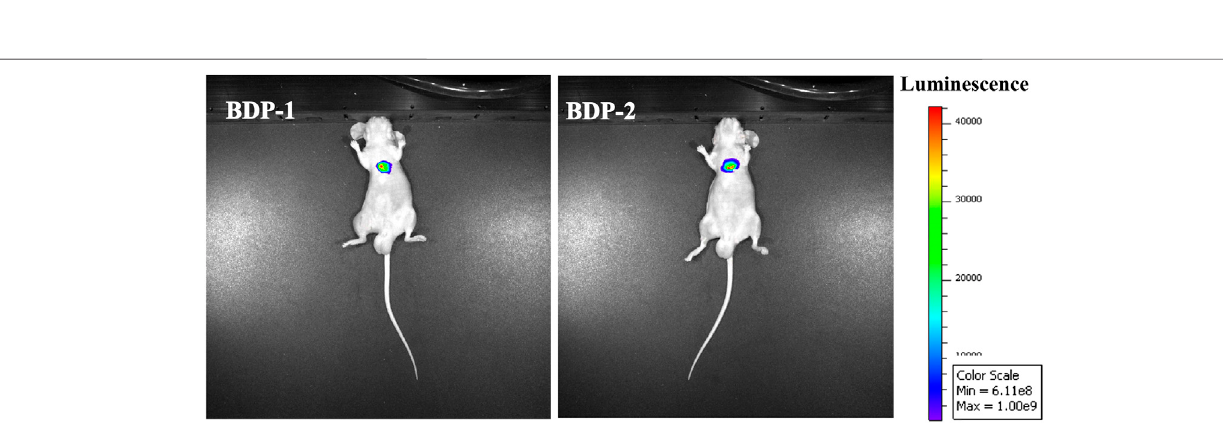
Frontiers in Chemistry |